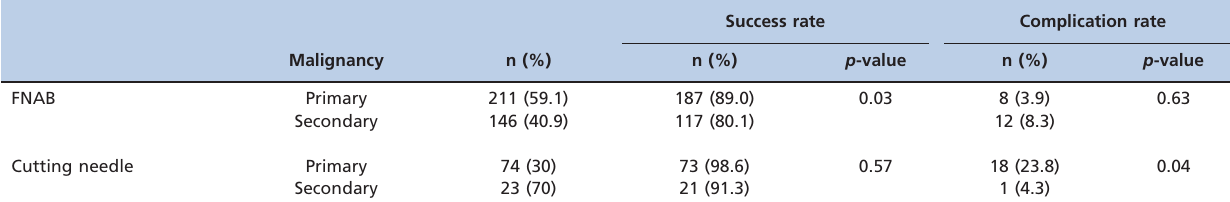
Table 5 - Success and complication rates of FNAB and cutting-needle biopsy according to the reason for the procedure (primary vs . secondary malignancy)